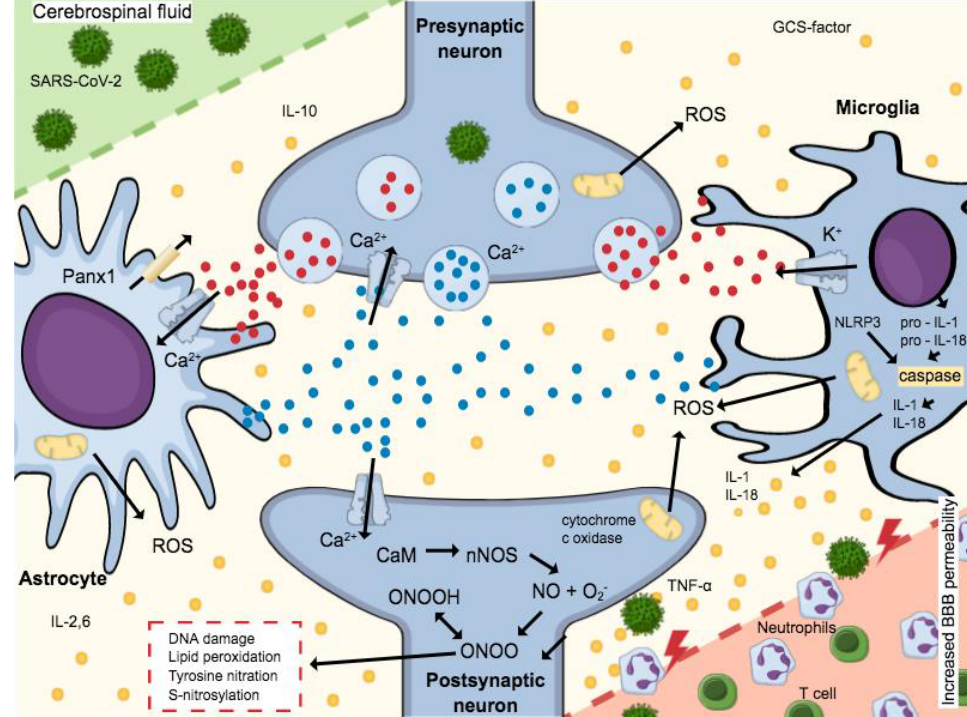
Figure 3. Microglia and astrocytes are activated by ATP expressed during the release of pro-inflammatory cytokines. NMDA receptors expressed by Glutamate activation allow the Ca2+-dependent exocytosis of ATP, thus releasing more Glutamate. A massive release of these neurotransmitters increases cell death and excitotoxicity, since postsynaptic neuron increased the Ca2+-calmodulin (CaM) complex formation and consequent nNOS activation. Neurotoxicity is mediated by NO production, which interacts with the iron–sulfur centers in the mitochondrial electron transport chain, and produces reactive oxygen species (ROS), impairing cellular energy production. Still, a reaction of O 2- (superoxide ion) and NO forms peroxynitrite (ONOO - ) and peroxynitrous acid (ONOOH). Such formation leads to oxidative stress, which includes DNA damage, lipid peroxidation, tyrosine nitration, and excess S-nitrosylation, causing neuronal impairment and/or death. The activation of caspase-1 is mediated by the NLRP3 inflammasome by the cleavage of pro-IL-1β and pro-IL-18 in IL-1β and IL-18, respectively. The mature forms of cytokines are secreted worsening the neuroinflammatory process established. Then, the neuroinflammatory process established can be worsened by these mature cytokines. Adapted from Ribeiro et al., 2021 [105].